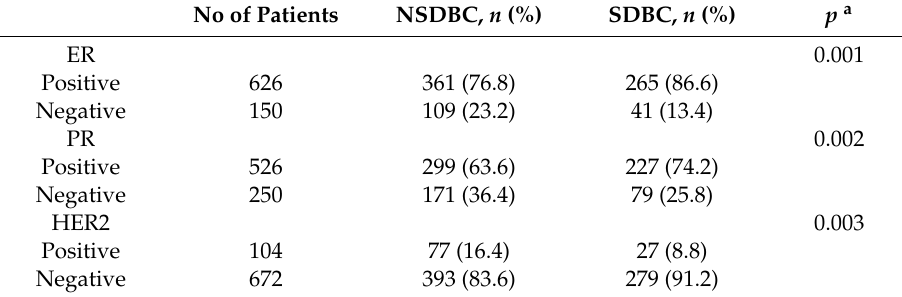
Table 3. Immunohistochemical di ff erences between NSDBC and SDBC